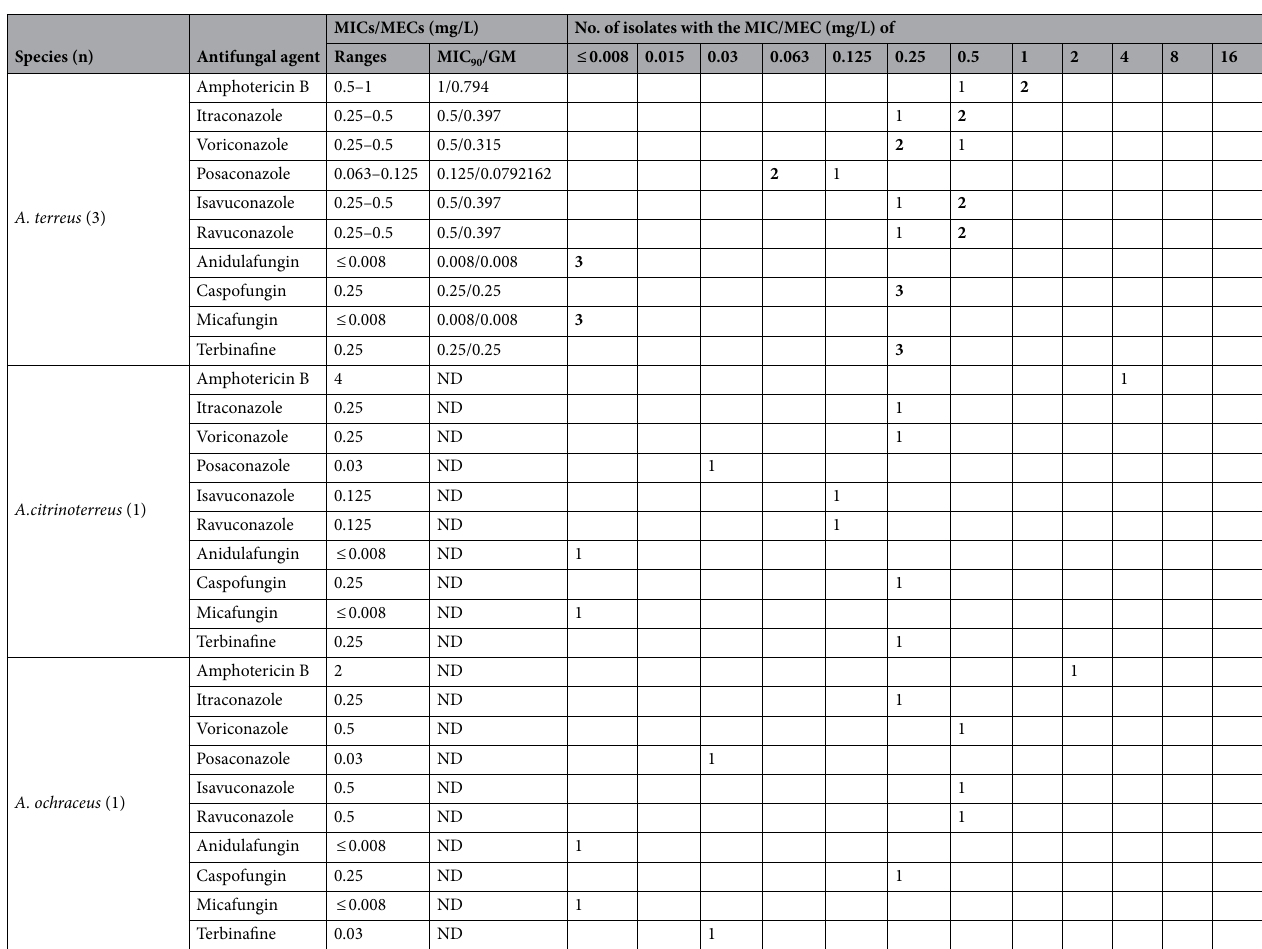
Table 2. Ranges MIC/MEC, Geometric mean MIC/MEC, Modal MIC/MEC, distribution of MICs/MECs of 10 antifungal agents against 48 Aspergillus isolates. Abbreviations: minimum inhibitory